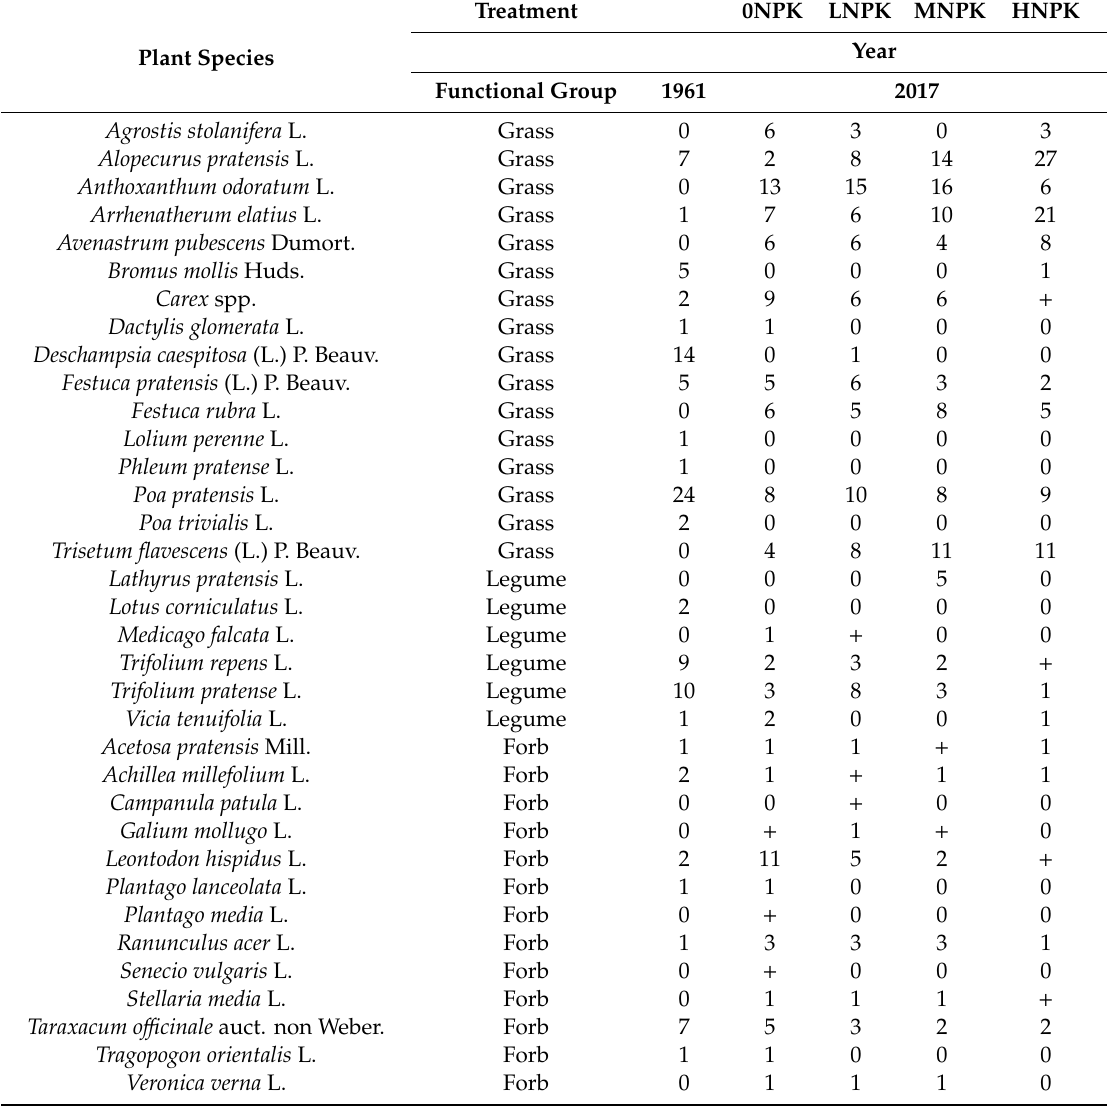
Table 3. Botanical composition (%) in 1961 and